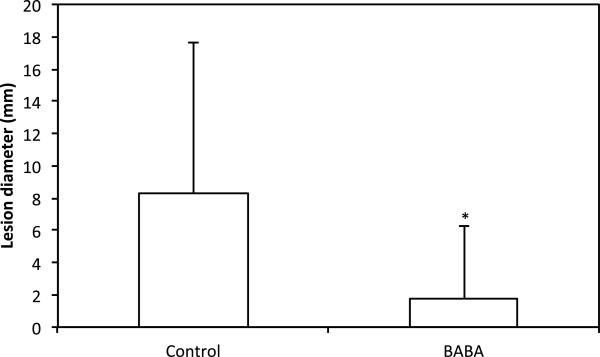
Detached leaf assay. Mean lesion sizes of P. infestans infection in potato leaves, 7 dpi. Leaflets (N = 18) were infected two days after treatment with BABA (10 mM) and water (control). Bars represent Standard Error of the mean. Treatment with a significant effect (p <0.05) is marked with *.